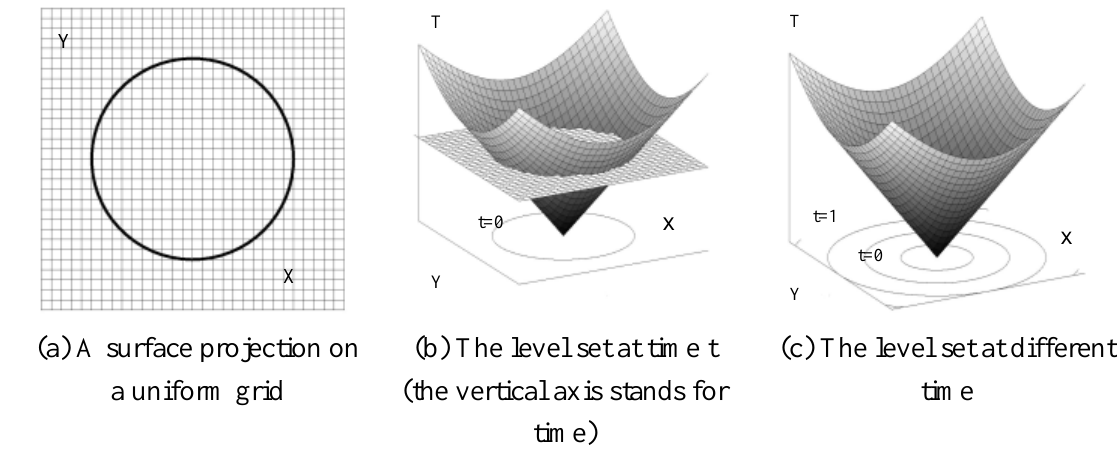
Figure 1. Illustration of level